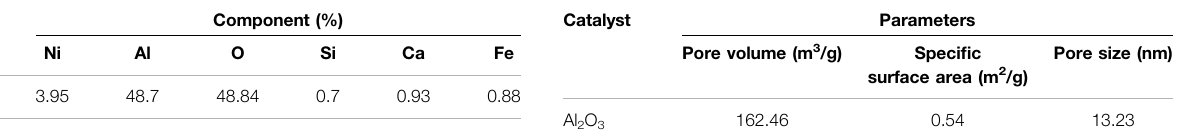
TABLE 1 | Composition of the Ni/Al 2 O 3 catalyst. TABLE 2 | Micro structure parameters of base and